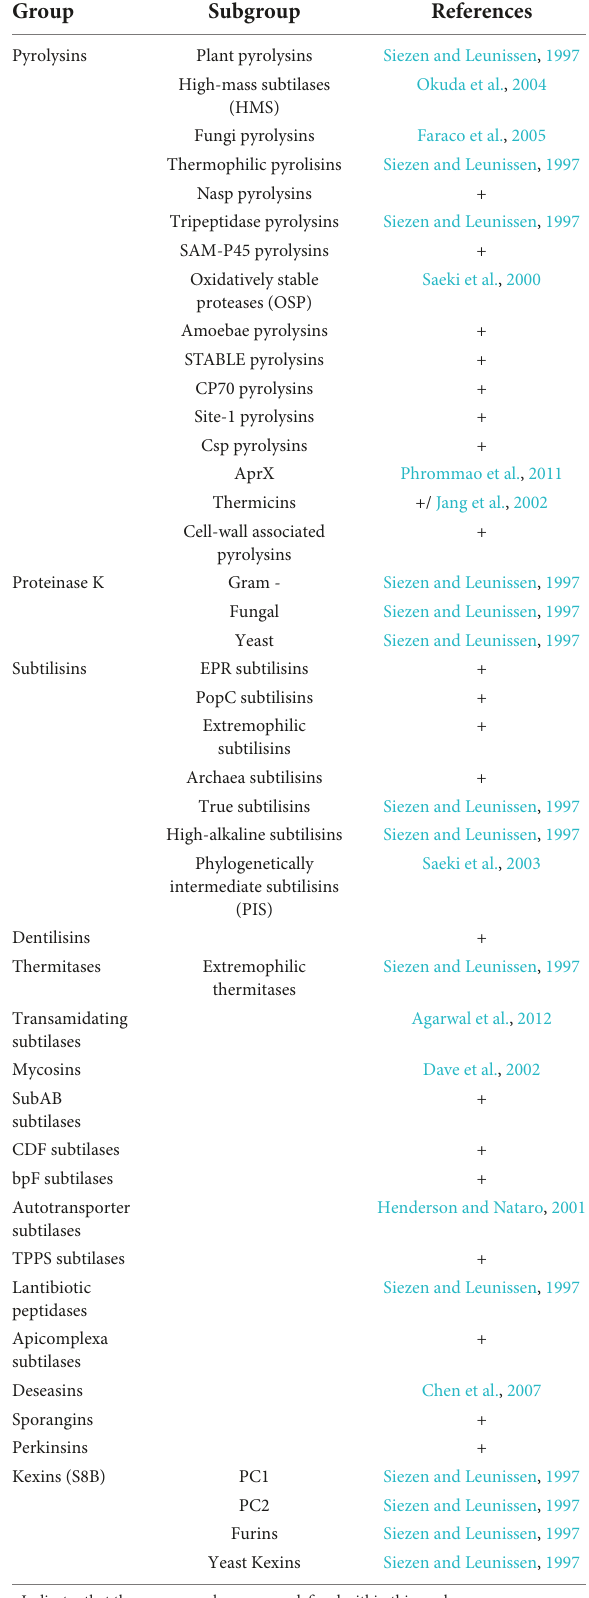
TABLE 1 Group and subgroups of the subtilase family.